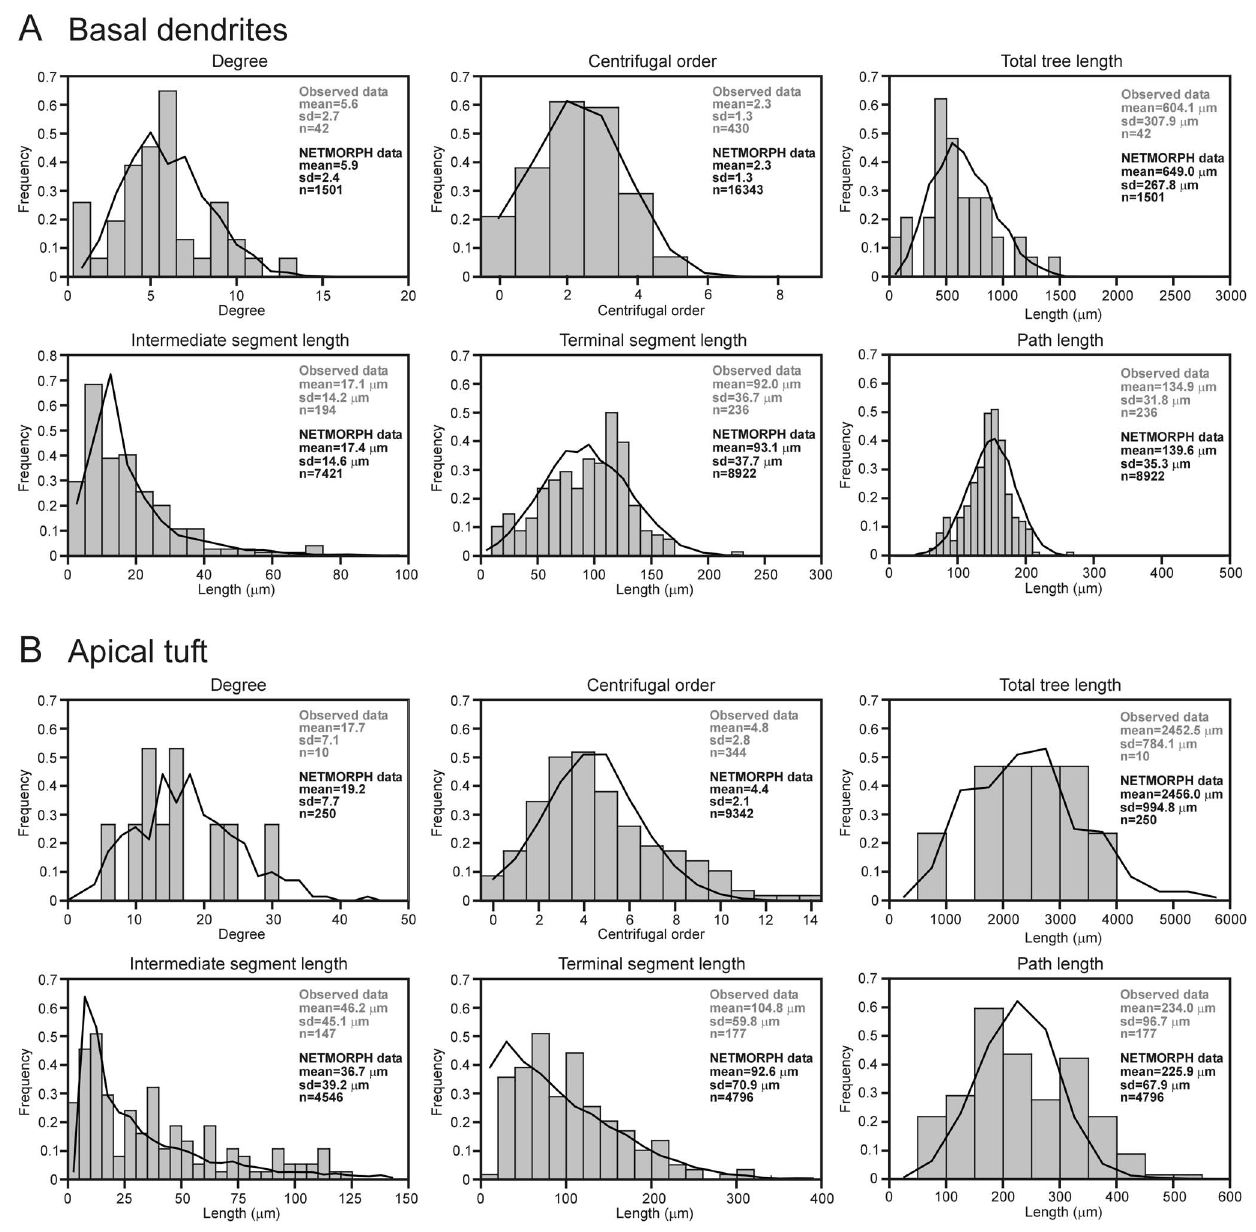
Figure 4. Distributions of dendritic shape characteristics of NETMORPH-generated and empirical L2/3 pyramidal cells. A , Basal dendrites. B , Apical tuft. The NETMORPH-generated neurons are shown by solid lines, and the L2/3 pyramidal neurons from the NeuroMorpho.org database are shown by grey bars. For the basal dendrites, the n-values of degree and total tree length refer to the total number of dendritic trees. For the apical tufts, the n-values of degree and total tree length refer to the total number of apical dendrites (equal to the number of neurons used). For both the basal dendrites and the apical tufts, the n-values of centrifugal order refer to the total number of segments (intermediate and terminal), the n-values of intermediate segment length refer to the total number of intermediate segments, and the n-values of terminal segment length and path length refer to the total number of terminal segments.